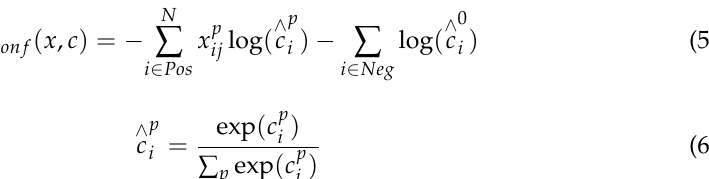
Figure 5. IOU schematic.